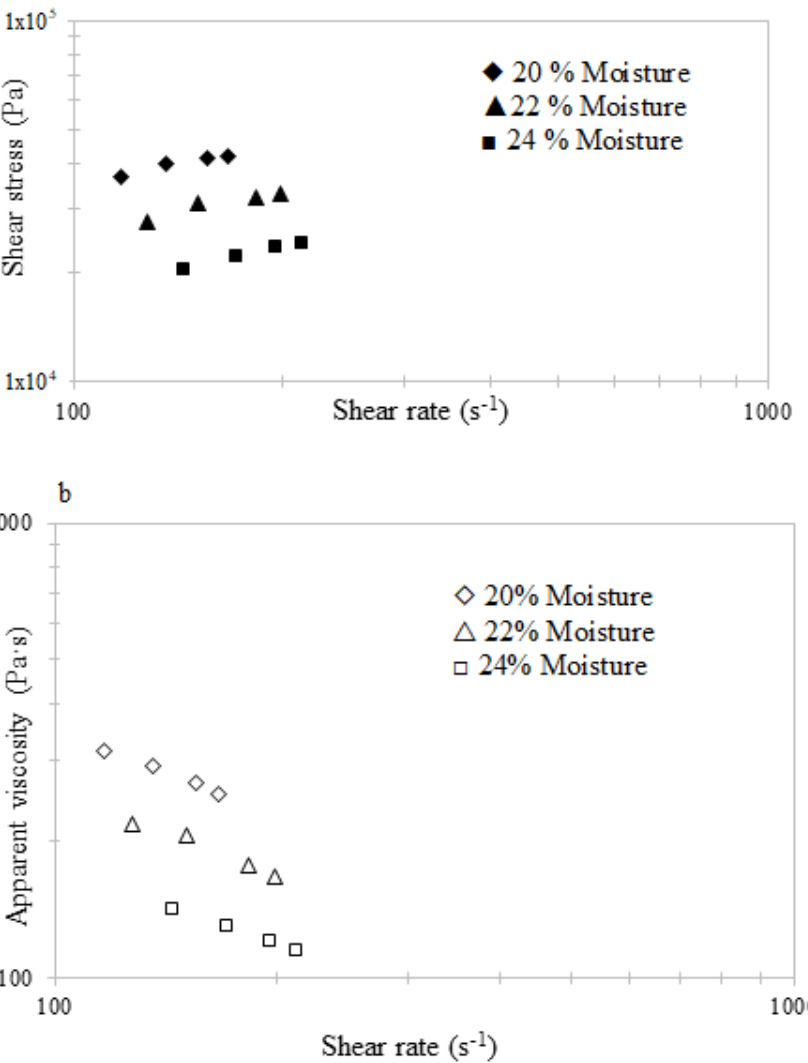
Figure 4. Effect of variation in hydrolyzed protein flour content on shear stress ( a ) and apparent viscosity ( b ) at 125 °C and 22% moisture. viscosity ( b ) at 125 ◦ C and 22%